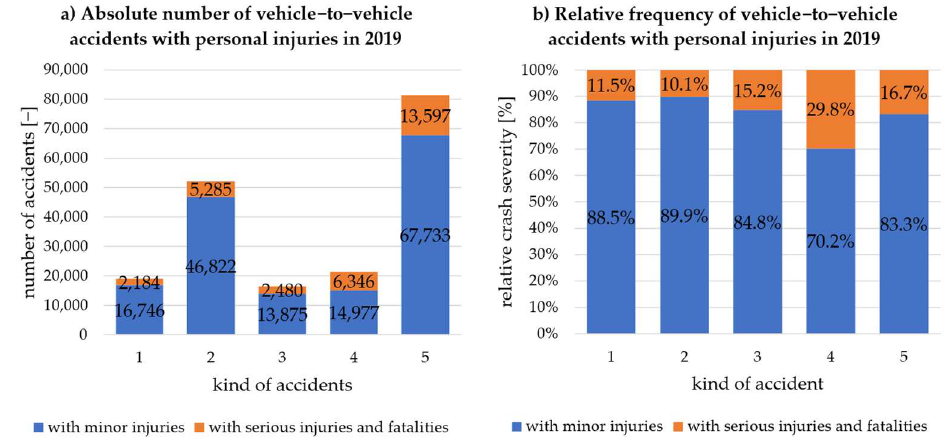
Figure 5. Vehicle-to-vehicle accidents with personal injury in 2019 according to Destatis [15]: ( a ) absolute number; ( b ) relative frequency.